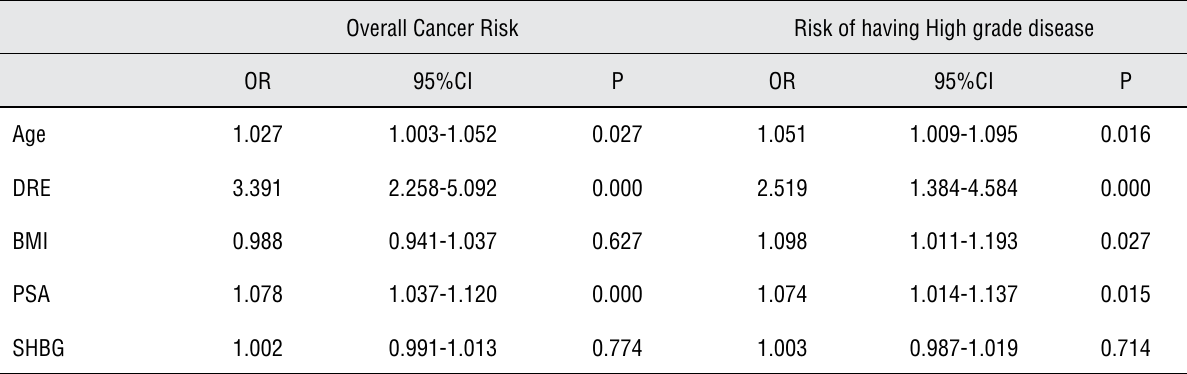
Table 3 - Exploring the association of SHBG and prostate cancer risk.